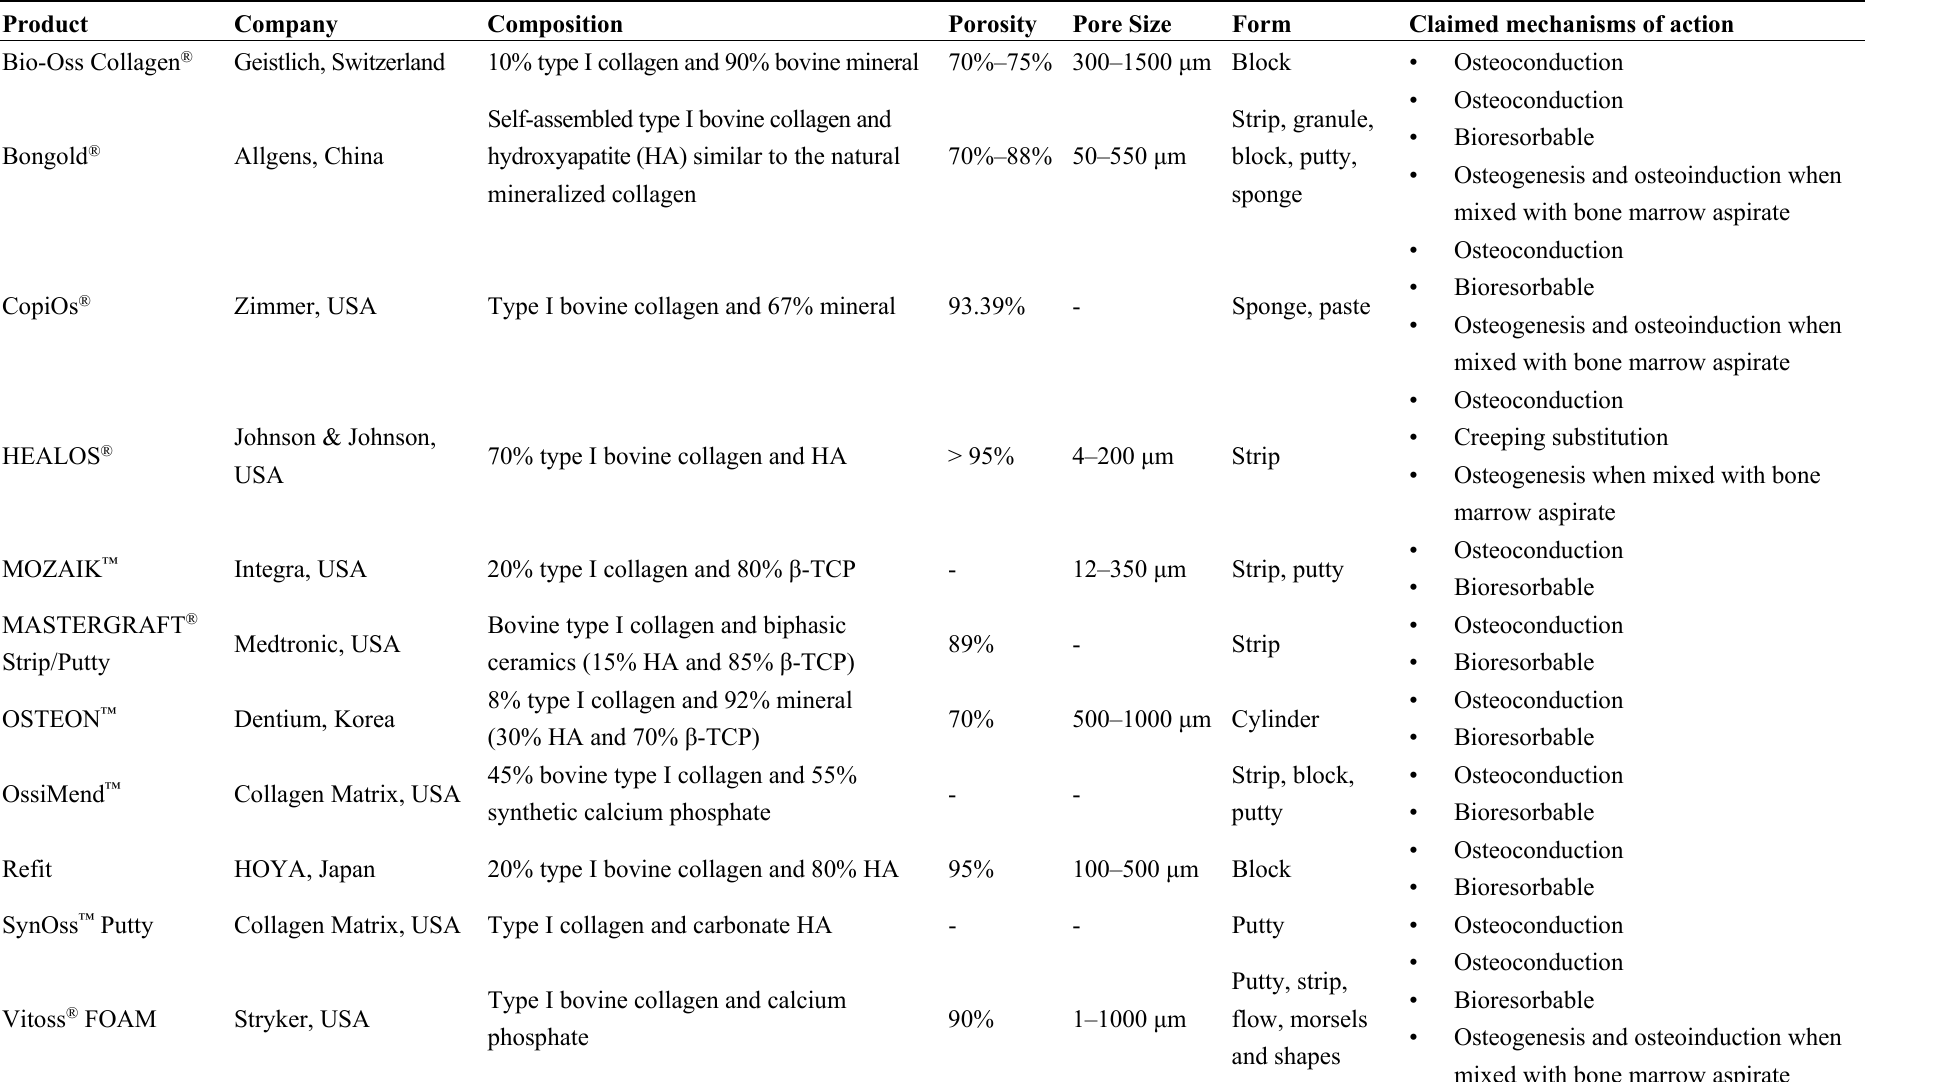
Table 1. Commercially available mineralized collagen